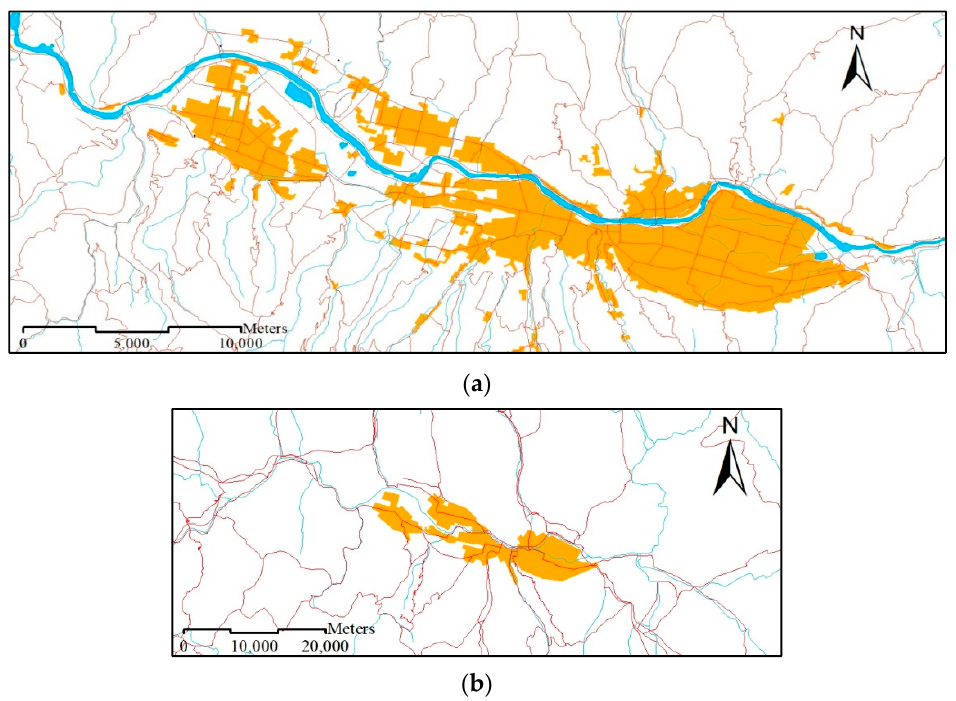
Figure 2. Vector datasets of Lanzhou City at the 1:250K and 1:1M scales: ( a ) 1:250K data and ( b ) 1:1M data.